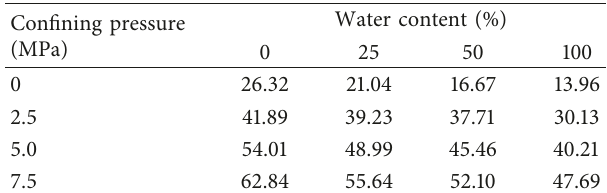
Table 1: Compressive strength depending on the water content and confining